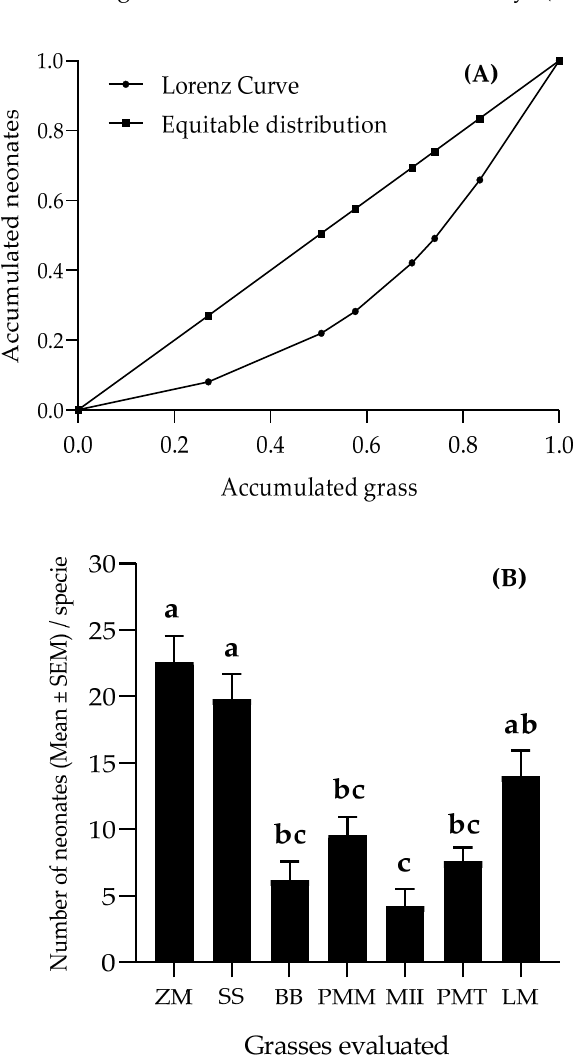
Figure 6. Lorenz curve ( A ) and histograms ( B ) of distribution of S. frugiperda neonates in the grasses. Bars topped by different letters indicate significant difference by the Tukey test ( α = 0.05). (ZM = Z. mays ; SS = S. sudanense ; BB = B. brizantha; PMM = P. maximum cv. Mombasa; MII = B. hybrid cv. Mulato II; PMT = P. maximum cv. Tanzania; LM = L. multiflorum ).